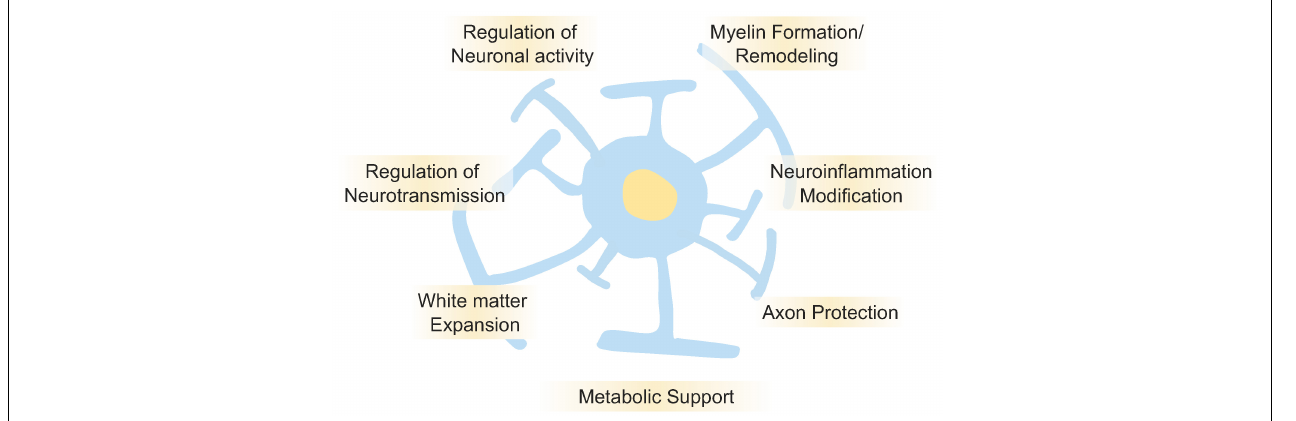
FIGURE 2 | Roles of oligodendrocyte in the brain functions. Oligodendrocyte plays essential roles for regulation and maintenance of brain functions. It is well known that oligodendrocyte regulates neuronal activities by myelin formation and its remodeling. It also regulates neurotransmission, neuroinflammation, axon protection, and metabolic supports. Oligodendrocytes are one of the major cell types that make up white matter, and in the human brain, the expansion of white matter is thought to have contributed to higher brain functions. Disruption of those oligodendrocyte’s functions is also thought to cause NDDs, psychiatric disorders, and cognitive